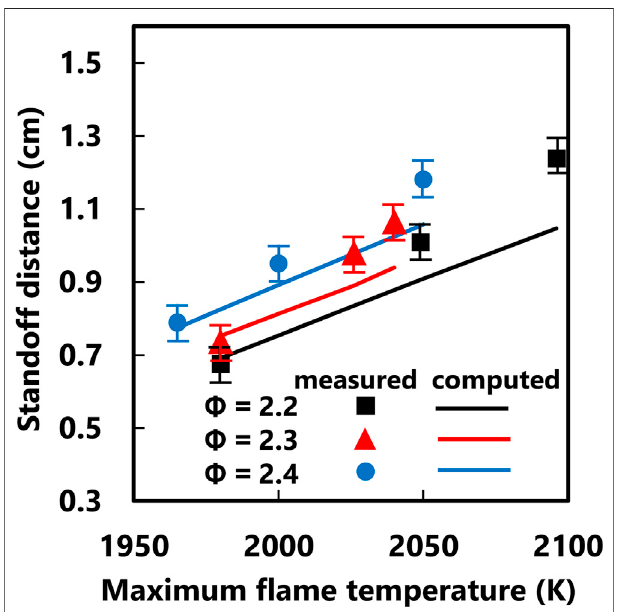
FIGURE 5 | Measured and computed fl ame standoff distance for the series of fl ames currently studied.